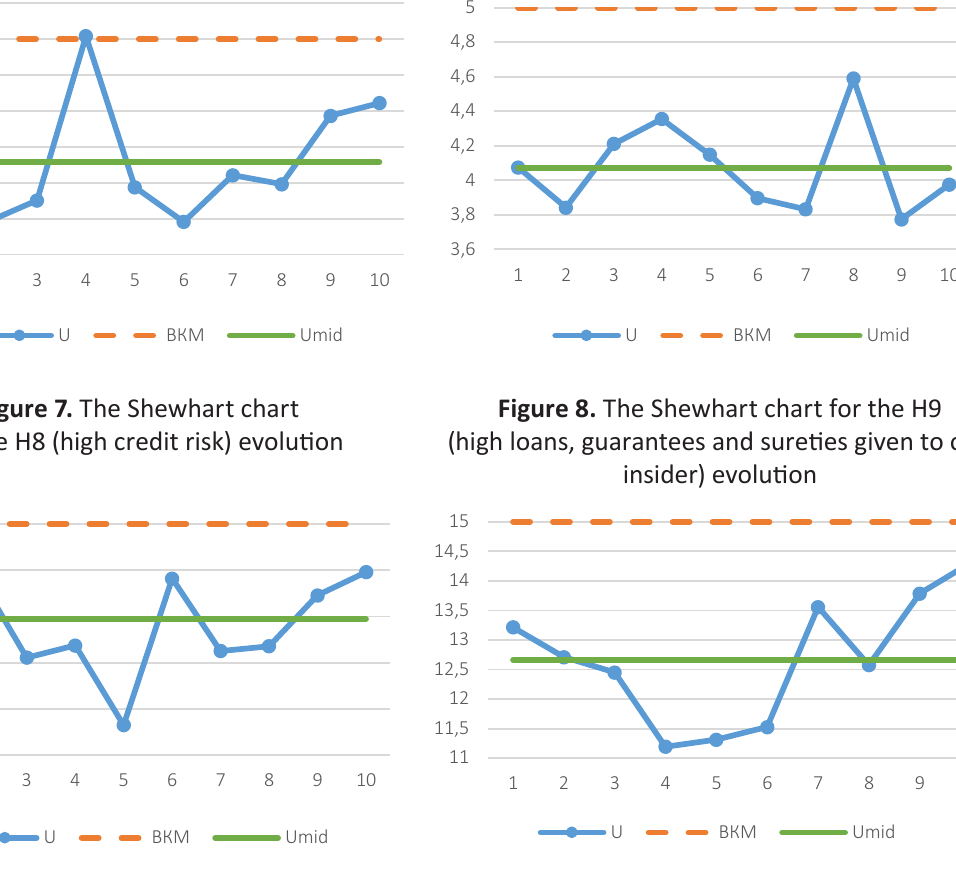
Figure 10. The Shewhart chart for the H11 (investment in securities separately for each institution)